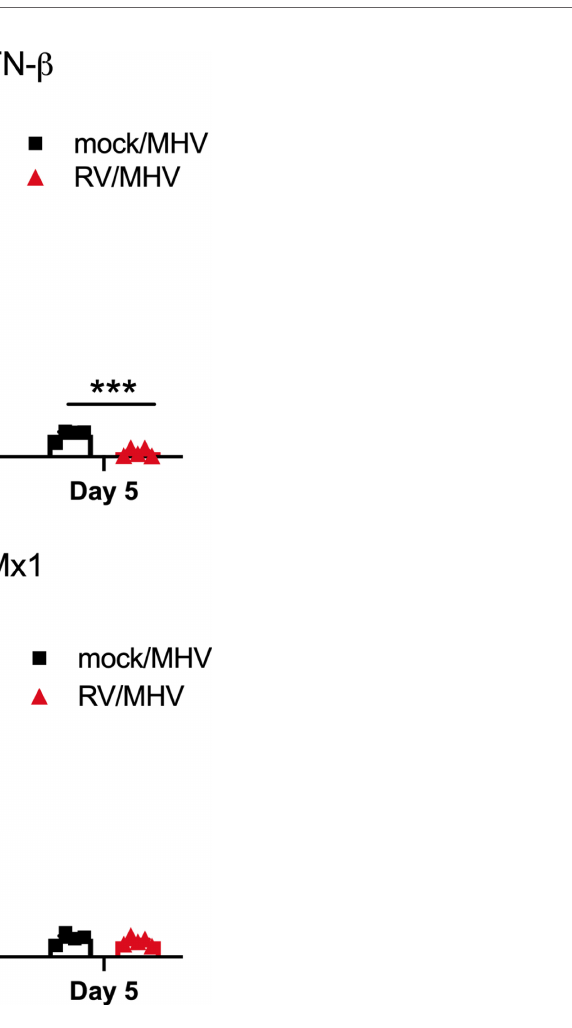
FIGURE 3 | Priming with RV results in reduced expression of type I IFN response genes. Mice (n=5 per group and time point) were inoculated intranasally with RV (7.6x10 6 TCID 50 ) or saline (mock) on day -2, and MHV-1 (2x10 5 PFU) on day 0. Total lung RNA was isolated and expression of (A) IFN- b and (B) Mx1 were quanti fi ed by RT-qPCR. **p<0.01,